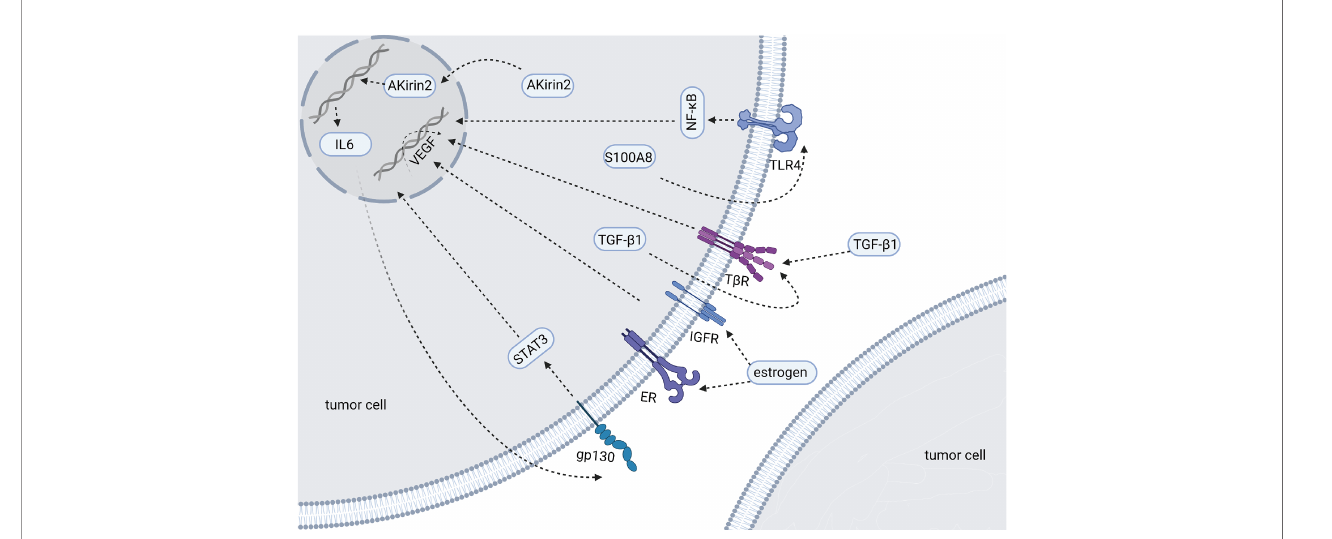
FIGURE 2 | Molecules and mechanisms regulating the expression of VEGF in BTCs (Created in BioRender.com). The fi gure mainly shows the factors have been reported to affect the expression of VEGF in BTCs. These factors are overexpressed in tumor cells and their downstream signaling pathways of affecting VEGF have been described by